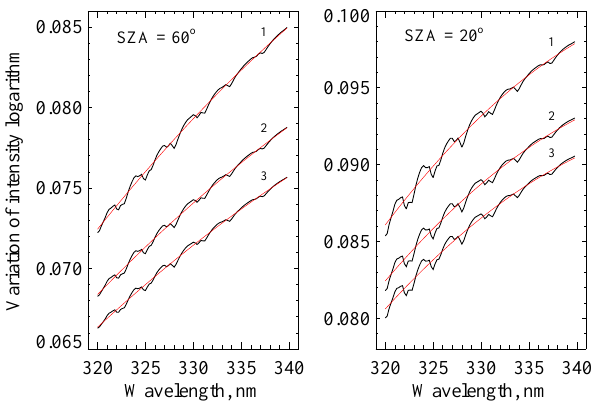
Fig. 1. Approximation of δt p (λ) (black) by a second order poly- nomial (red). The results are obtained for the Rayleigh scattering coefficient increased by 10%, surface albedo increased by 10%, and aerosol extinction coefficient increased by 25, 15, and 10% (marked in plot by 1, 2, and 3,